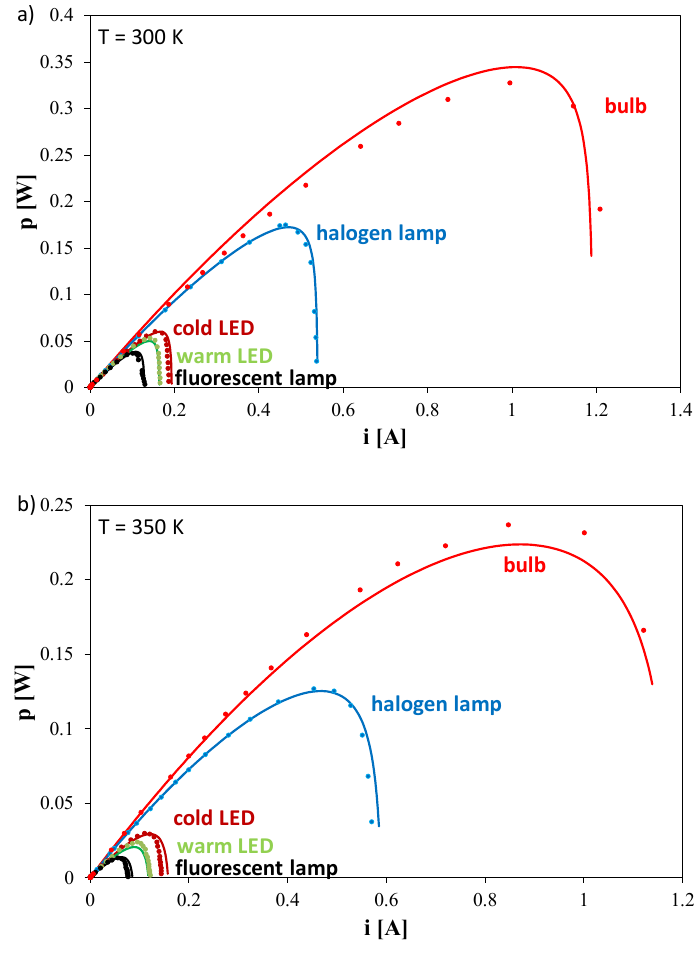
Figure 8. The measured and computed dependences of power generated in the monocrystalline solar cell on its current by irradiation of the considered lighting sources at temperature T = 300 K ( a ) and T = 350 K ( b ).